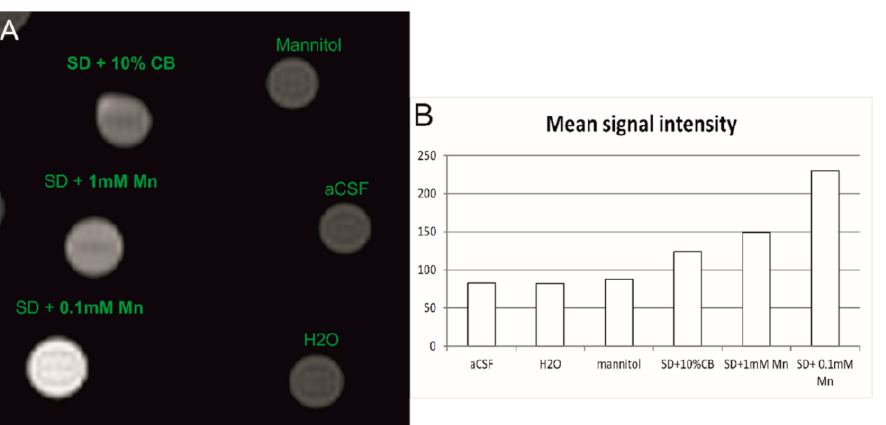
Figure 8. T1-weighted MR images of hydrogel phantoms containing 1 mM and 0.1 mM Mn 2+ and compact manganese alginate particles ( A ). Mean MR signal intensity measured with the same region of interest (ROI) size ( B ). Mannitol, aCSF and H 2 O was used as a control signal during T1-weighted MR imaging.